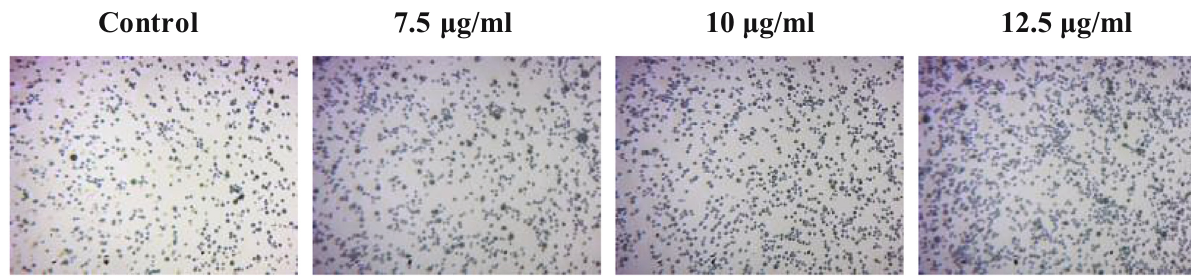
Figure 10: E ff ect of ZnO NPs on cell adhesion in MDA - MB - 231